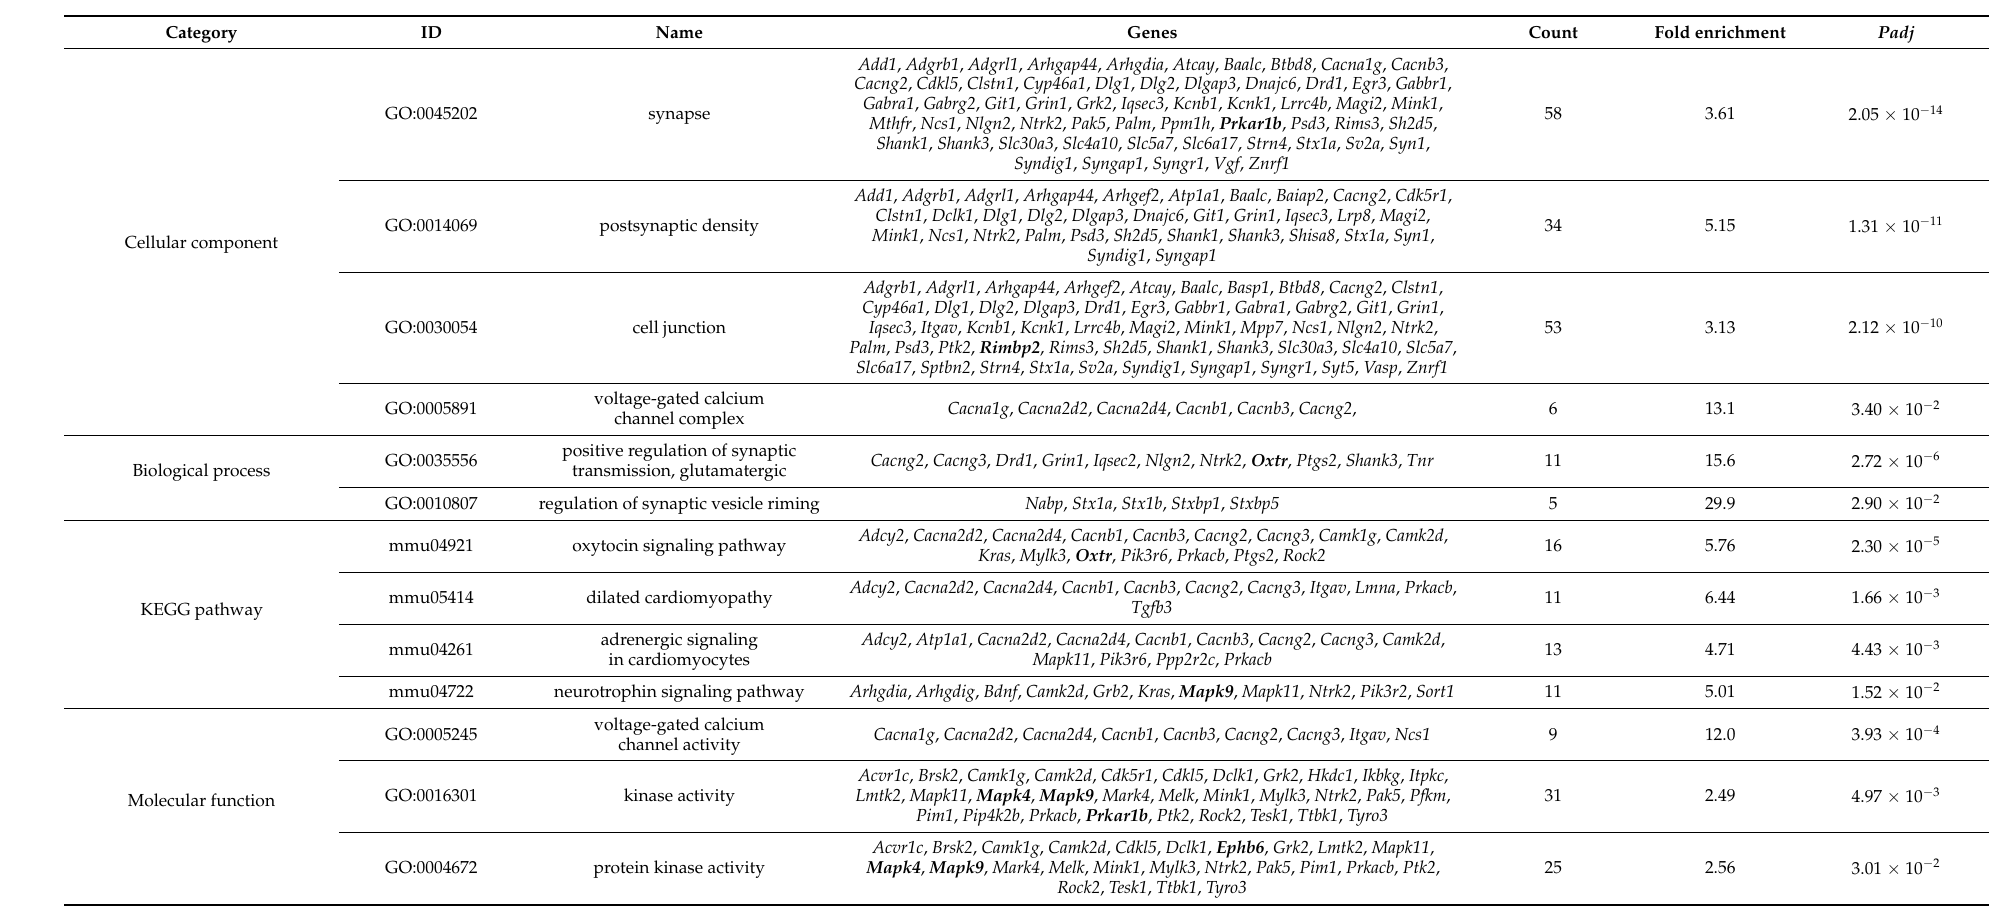
Table 4. Ontological analysis of upregulated genes (consensus and portrait scores ≥ 2) after FLX treatment in stressed